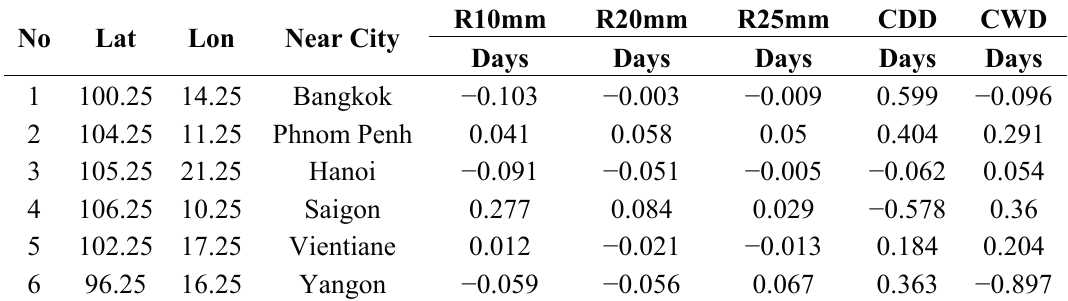
Table 4. The trends of frequency indices close to major cities in the Indochina Peninsula.